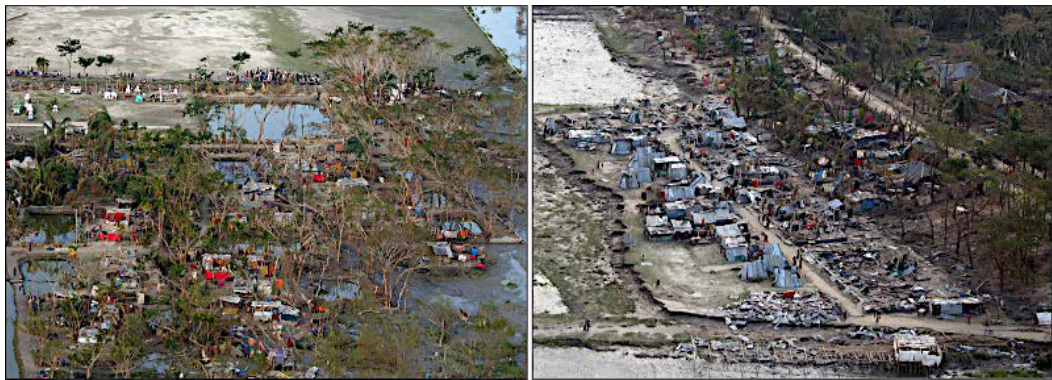
Figure 3. An aerial view of the damage to villages and infrastructure following Cyclone Sidr on the southern coast of Bangladesh. Source: The US Marine Corps, 24 November 2007 [43].